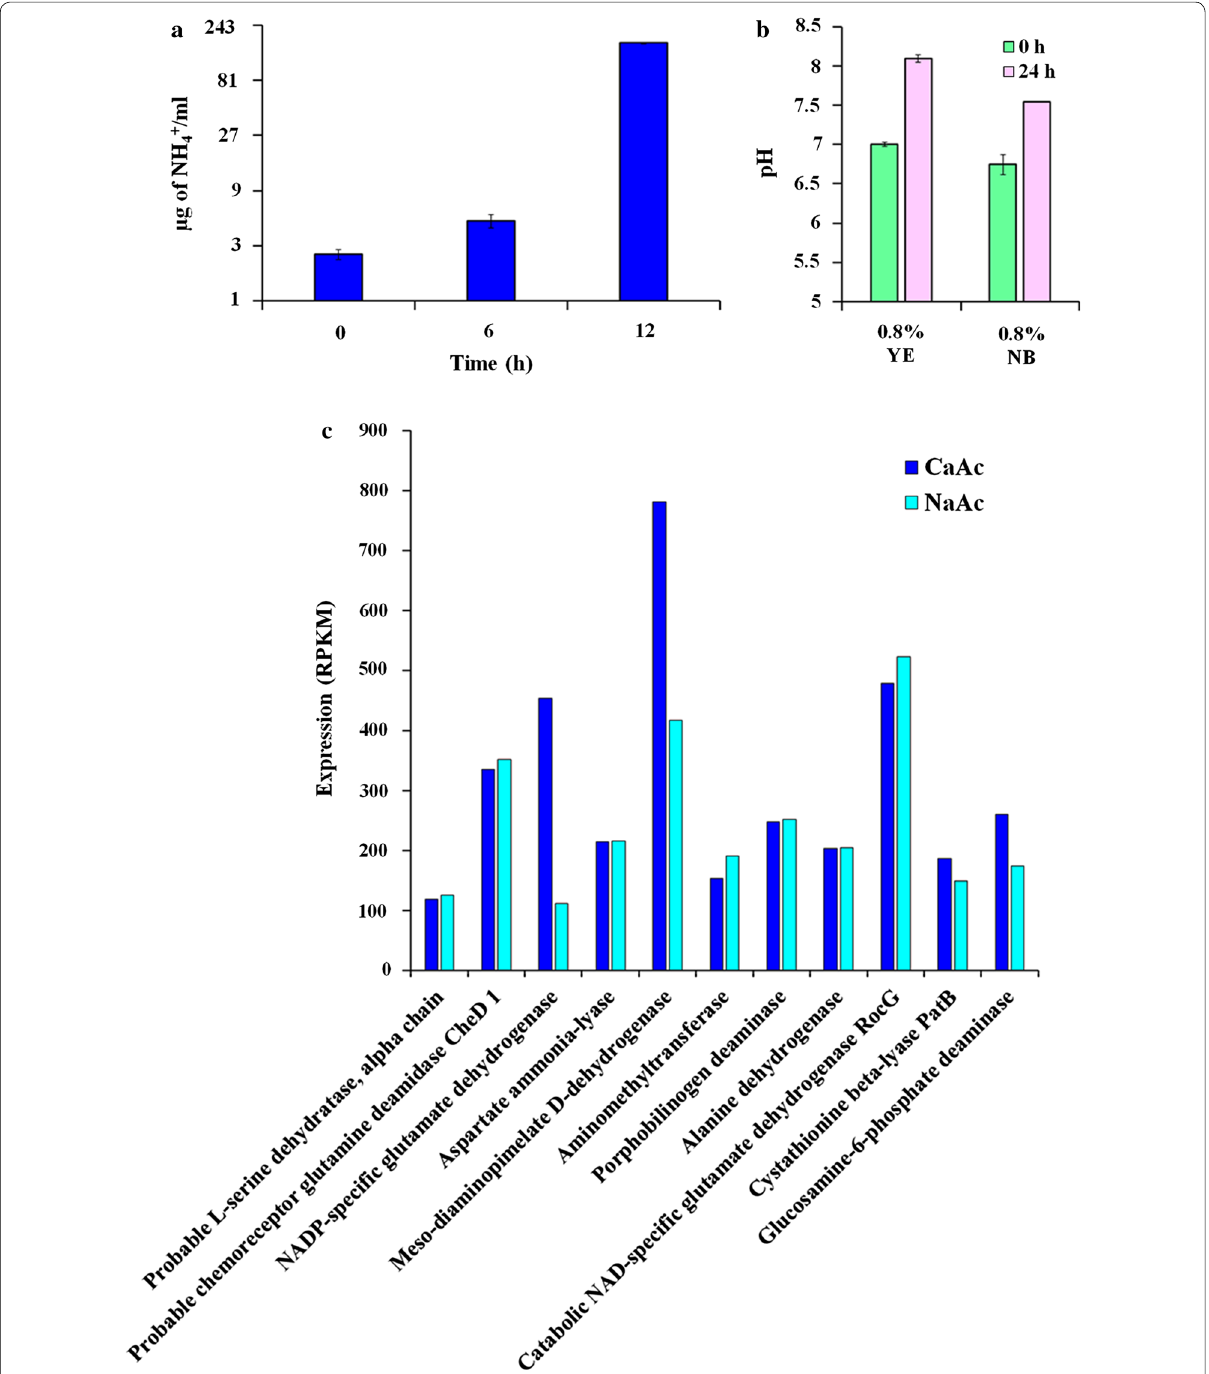
Fig. 2 a Quantification of ammonia production from supernatant of YS11 cultured in YL medium. b pH increases by YS11 in amino acid rich media (.8% yeast extract or .8% nutrient broth). c Expression of ammonia releasing genes from YS11 that exhibited RPKM value higher than